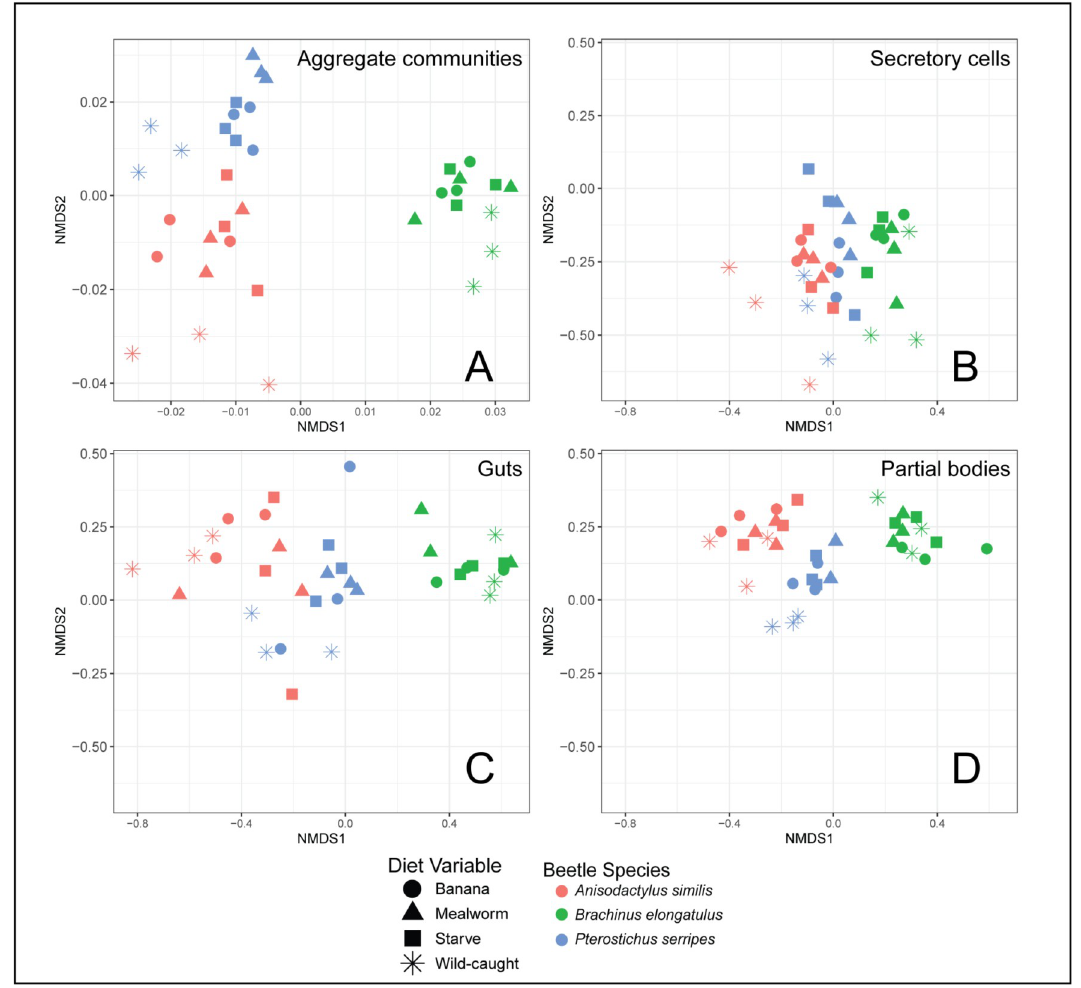
Fig 2. Bray-Curtis ordination of microbiome beta diversity using non-metric dimensional scaling. (A) Aggregate communities clustered significantly by species (ANOSIM R statistic = 0.92, p < 0.001) and tissue (R = 0.66, p < 0.001) only. (B) Secretory cell microbiomes clustered by species (R = 0.28, p < 0.001) and diet (R = 0.23, p < 0.001). (C) Gut microbiomes clustered clearly by species (R = 0.96, p < 0.001), and not by diet. (D) Partial body microbiomes are also clustered clearly by species (R = 0.95, p < 0.001), and not by